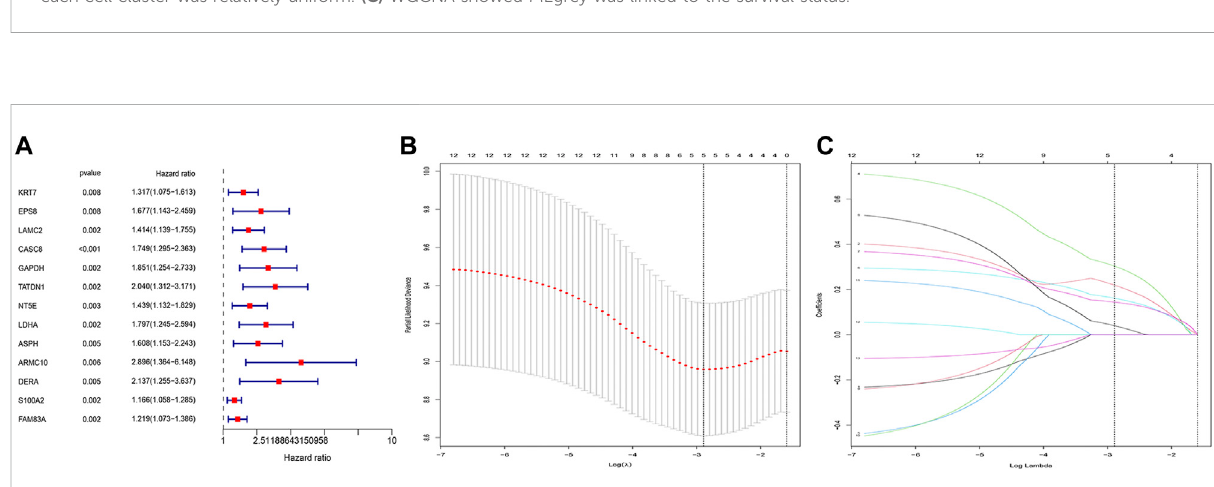
FIGURE 2 CDRG-basedprognosticmodelconstruction. (A) UnivariateCOXanalysis.Thereare13high-riskCDRGs,includingKRT7,EPS8,LAMC2,CASC8, GAPDH, TATDN1, NT5E, LDHA, ASPH, ARMC10, DERA, S100A2, and FAM83A. (B,C) LASSO regression analysis. We performed LASSO regression analysis on these 13 genes. We fi nally obtained 5 modeling genes, which were EPS8, CASC8, TATDN1, NT5E, and LDHA. Risk score